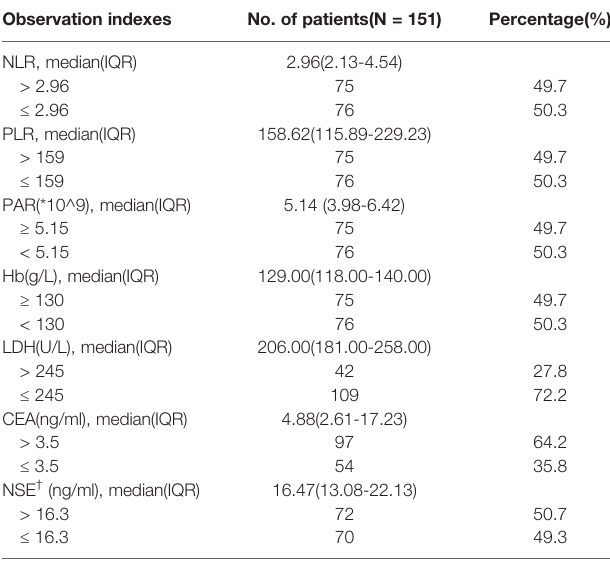
TABLE 2 | Patients ’ peripheral blood indexes before treatment (0